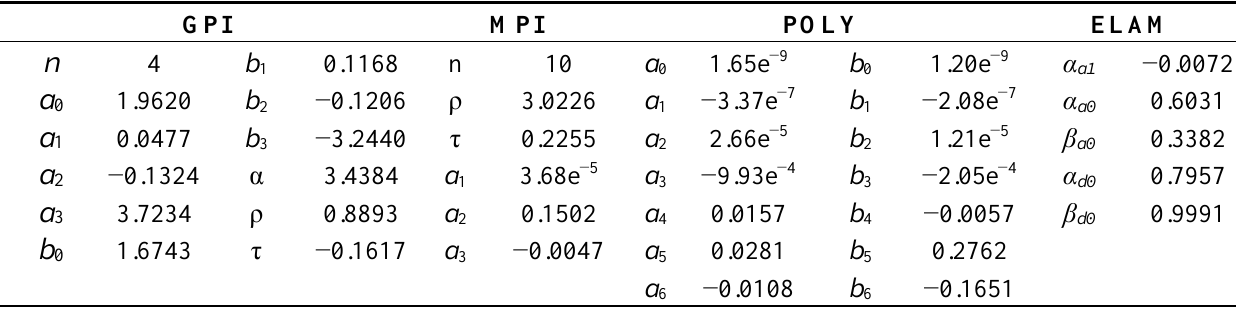
Table 3. Parameters of the models for the ascending hysteresis curves of the tactile sensor.